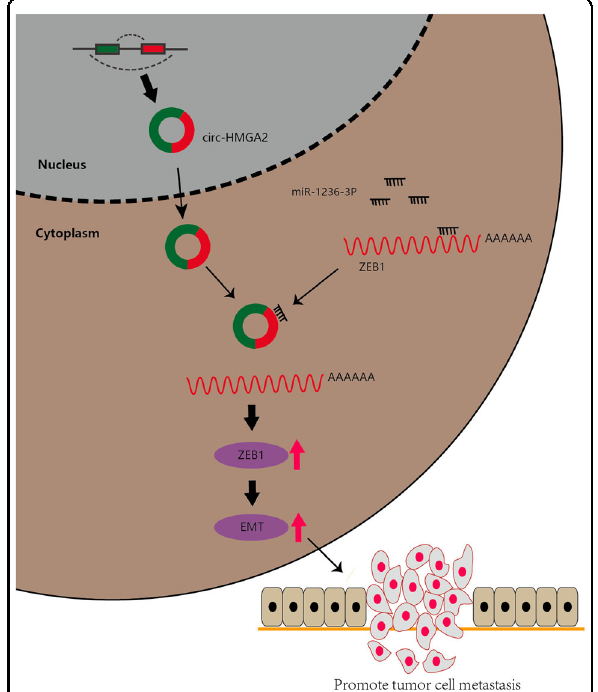
Fig. 7 The circ-HMGA2/miR-1236-3p/ZEB1/EMT axis regulates LUAD cell metastasis. Circ-HMGA2 is highly expressed in lung adenocarcinoma and acts as a sponge of miR-1236-3P to promote the expression of ZEB1. ZEB1 acts as a transcription factor of EMT, promoting the progression of EMT and the metastasis of lung